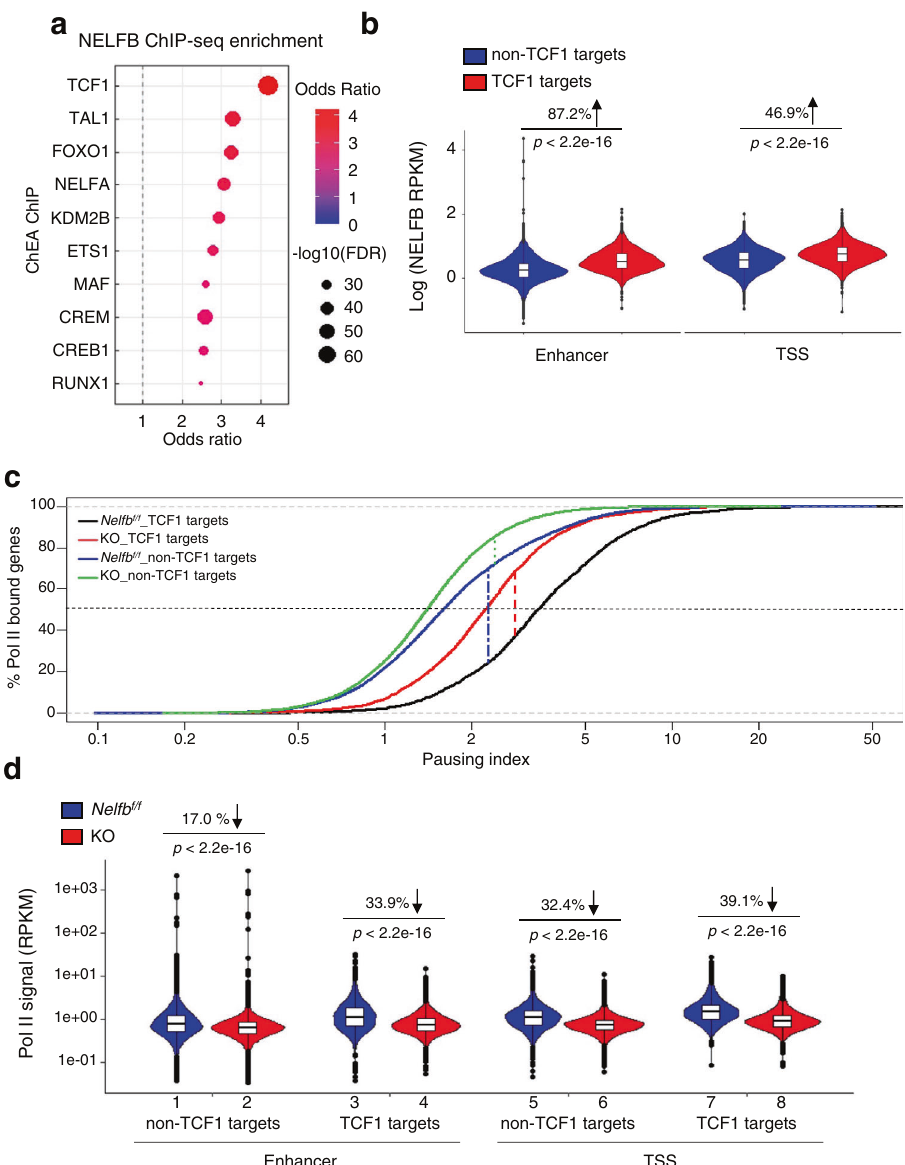
Fig. 5 NELF-mediated Pol II pausing at cis -regulatory elements of TCF1 targets genes. a Enrichment analysis of NELFB ChIP-seq of WT CD8 + T cells. b NELFB binding signals at enhancer and TSS regions of TCF1 and non-TCF1 targets of WT CD8 + T cells. c Cumulative curve of a pausing index for TCF1 and non-TCF1 targets in Nelfb f/f and KO CD8 + T cells. Dashed vertical line denotes the maximum difference in vertical distance between two cumulative distributions. d Pol II signals at enhancer and TSS regions of TCF1 or non-TCF1 targets of Nelfb f/f and KO CD8 + T cells. The bounds of the box represent the 25th and 75th percentiles of the interquartile range. The black line in the box interior represents the median of the data. The whiskers represent the minimum and maximum values of the data and the black dot outside the box and the whiskers represent an outlier. Violin plots were assessed by a two- sided Wilcoxon rank-sum test with continuity correction. For Pol II ChIP-seq analyses, n = 2 biological